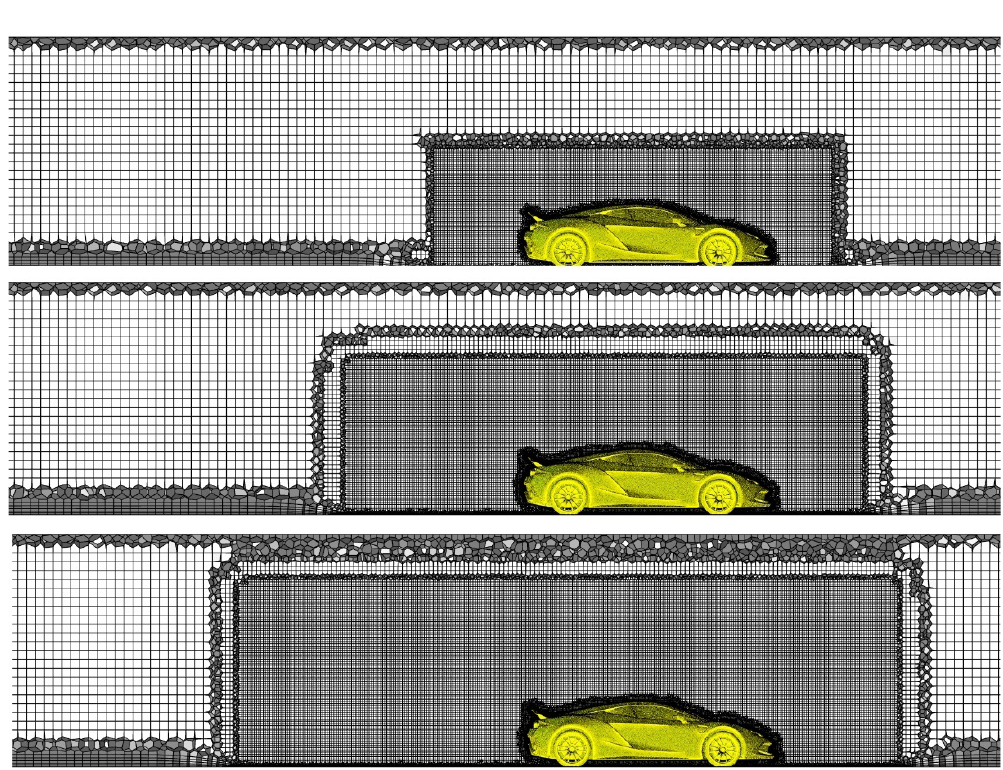
Figure 9. Meshes with different body of influence sizes. Table 1. Dimensions of the body of influence zone outside the outline of car.